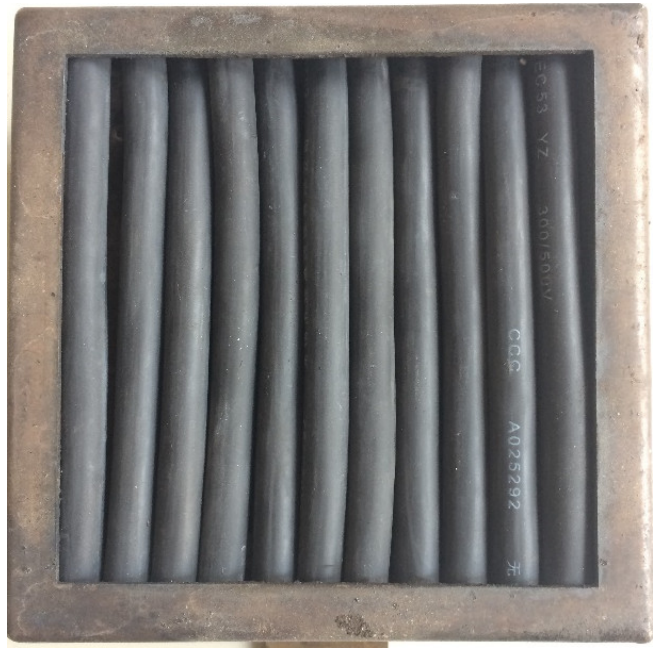
Figure 1. Cable structure.